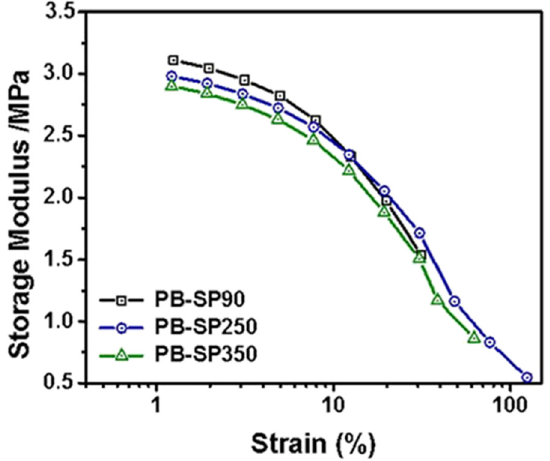
Figure 14: The dynamic storage modulus of PB - SP ( 90/250/350 nm ) with di ff erent size SiO 2 [ 84 ] ; Copyright: 2018 with permission from Wiley.